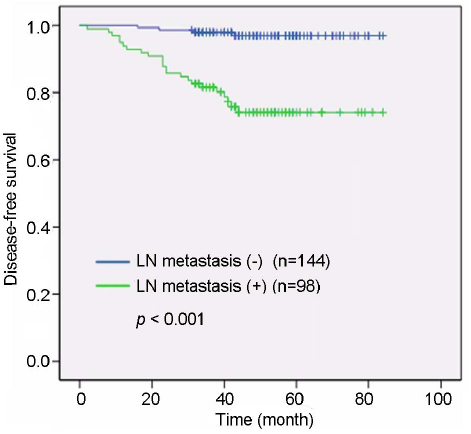
Figure 3. A significant association was determined between lymph node involvement and disease-free survival. A univariate analysis showed that patients with lymph node involvement had shorter disease-free survival durations than patients without lymphatic metastases (P , 0.01).